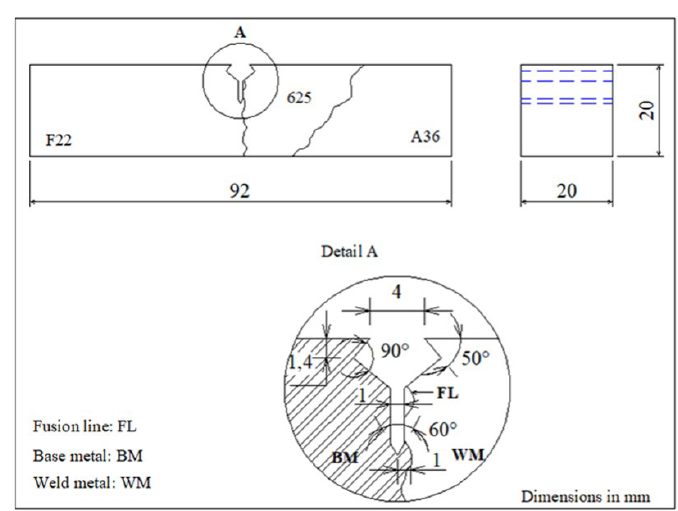
Figure 6. Location of the fatigue pré-crack in CTOD welded joint